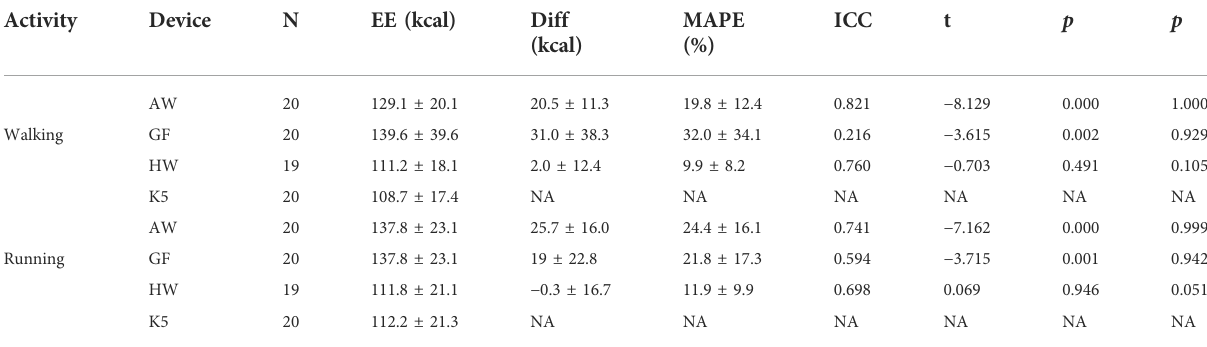
TABLE 2 Descriptive examination of the differences between the estimated EE (smartwatches) and the measured EE (K5) during the outdoor walking and running.